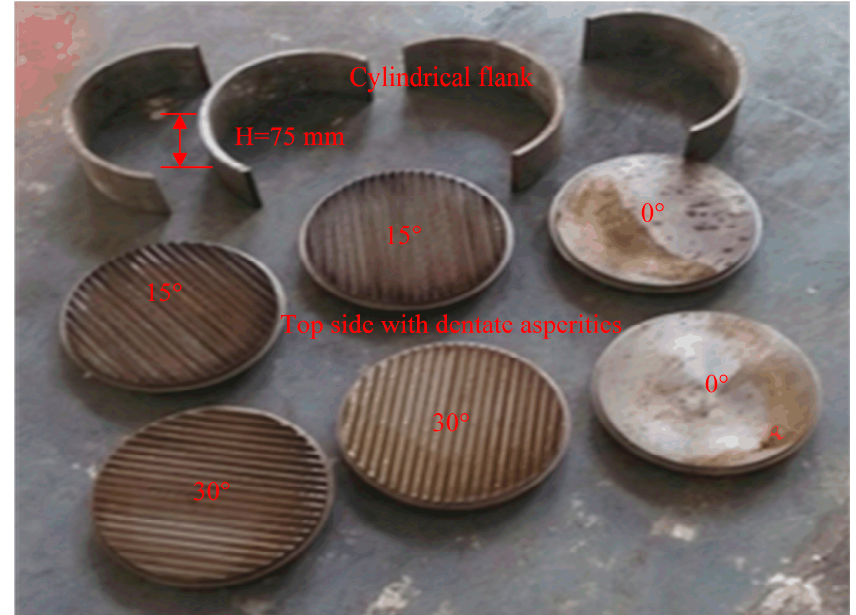
Figure 2. Molds for sample preparation.